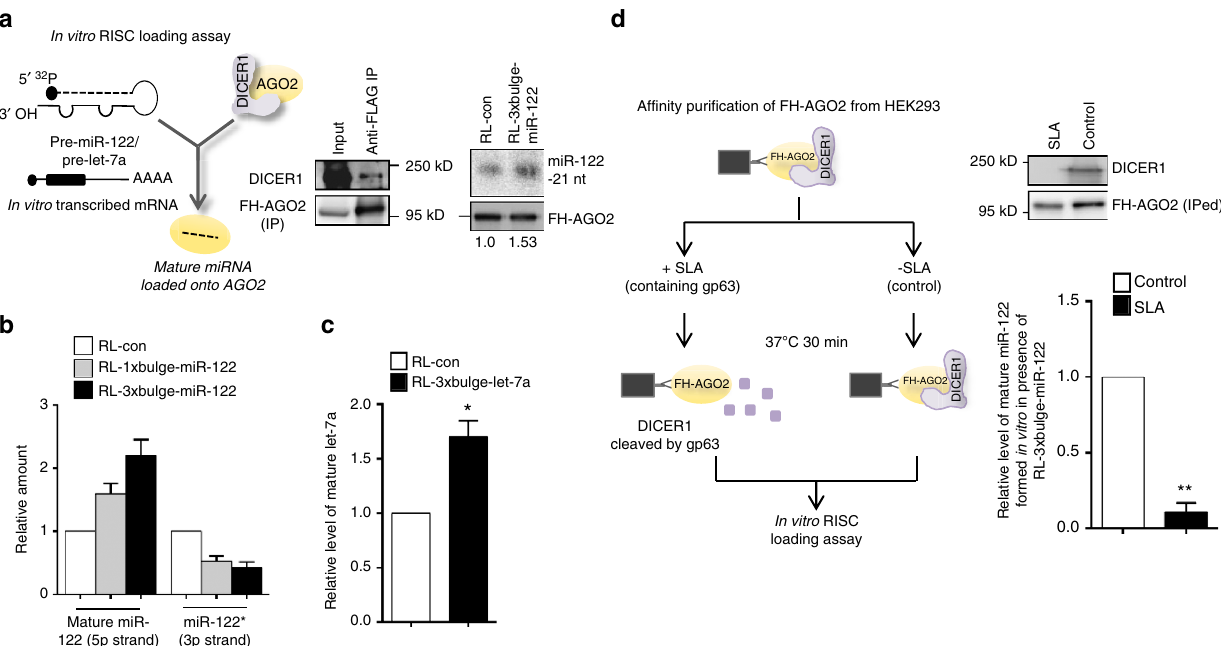
Figure 5 | Increased activity of AGO2-associated DICER1 contributes to the target mRNA-driven miRNA production. ( a – c ) Increased DICER1 activity in the presence of target mRNA contributes to enhanced miRNA production from pre-miRNA in vitro. Scheme of the in vitro RISC loading assay has been depicted in the upper panel. Immunoprecipitated FH-AGO2 isolated from HEK293 cells stably expressing the protein was subjected to loading assay with 10nM pre-miR-122 and 25ng m l (cid:3) 1 of respective target mRNAs. Quantification was done either by densitometry ( a ) or quantitative reverse transcriptase PCR (qRT-PCR) ( b ). The amount of mature miR-122 formed was normalized to the amount of AGO2 immunoprecipitated for quantification. Immunoprecipitation of FH-AGO2 and associated endogenous DICER1 was confirmed by western blotting. Increased DICER1 activity in the presence of target mRNA RL-3 (cid:2) bulge-let-7a contributes to enhanced miRNA production from pre-let-7a in vitro ( c ). ( d ) Removal of AGO2-associated DICER1 impairs target-driven miRNA biogenesis. Scheme of experiment has been shown. Lysate of FH-AGO2-stable HEK293 cells were treated with SLA and FH-AGO2 were immunoprecipitated for in vitro loading assay. Quantification was done by qRT-PCR. Paired two-tailed Student’s t -tests were used for all comparisons. * P o 0.05,** P o 0.01 and *** P o 0.001. For b – d , values plotted are means from at least three biological replicates. Error bars represent